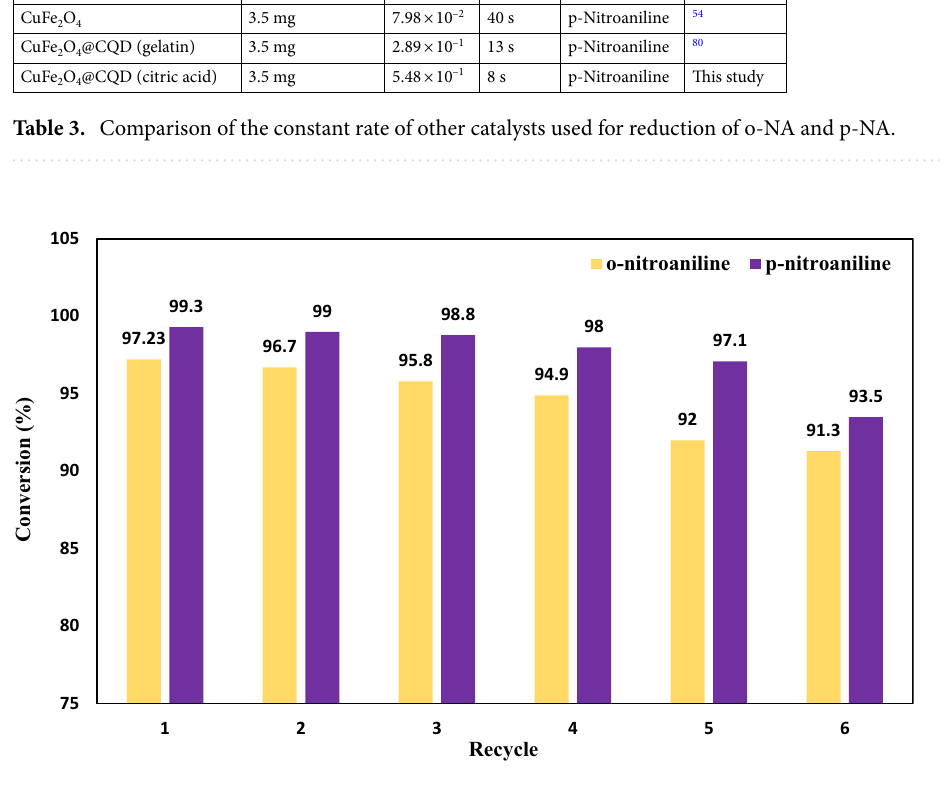
Figure 15. Recycle of nanocatalyst for up to 6